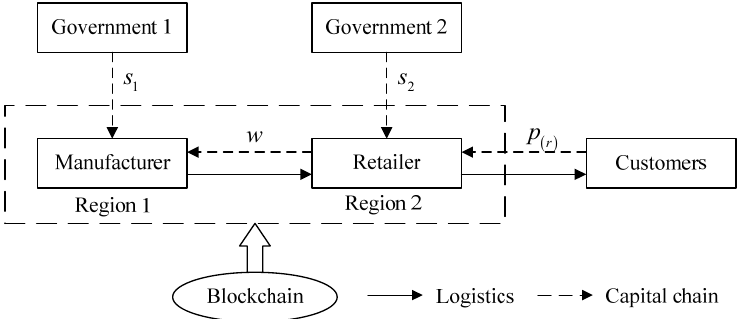
Figure 4. The structure and interaction process of FPSC system in Strategy SS.